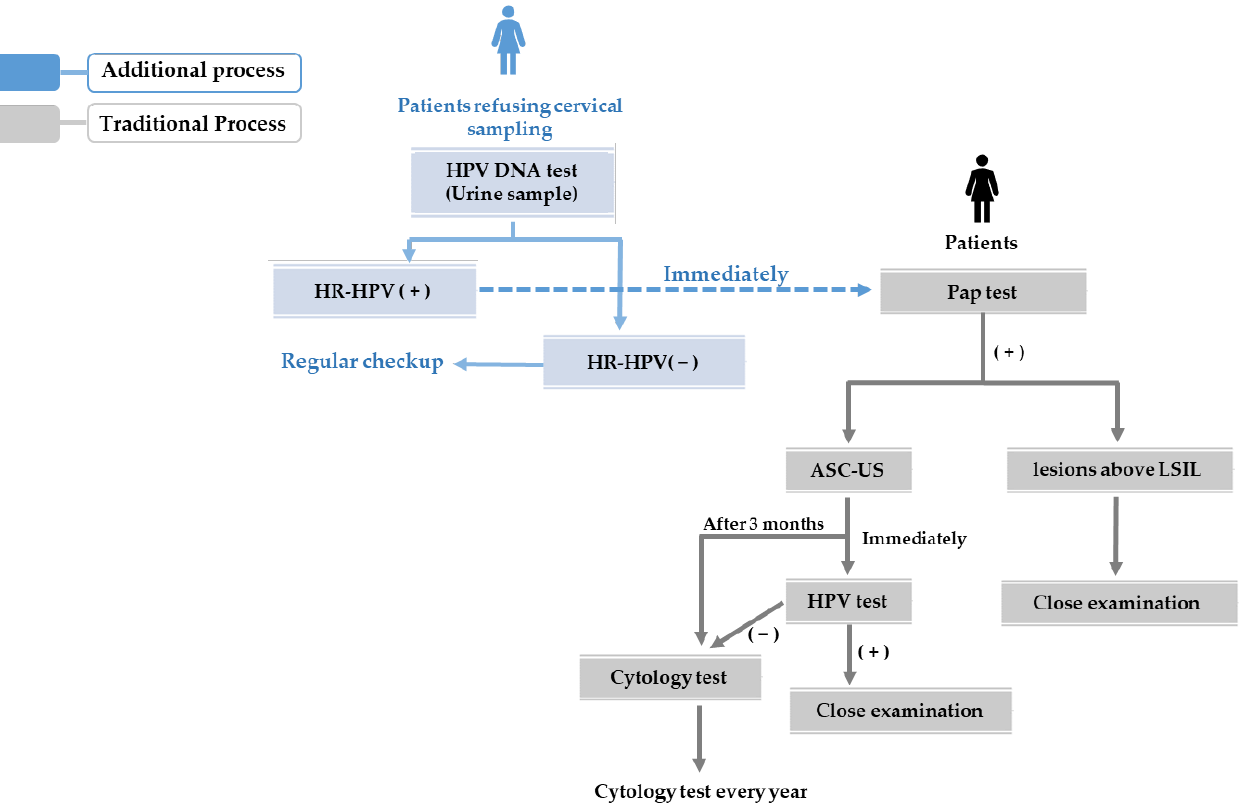
Figure 1. Proposal of additional cervical screening process for the prevention of HR-HPV infection in women who refuse invasive cervical sampling. ASC-US; atypical squamous cells of undetermined significance, LSIL; low grade squamous intraepithelial